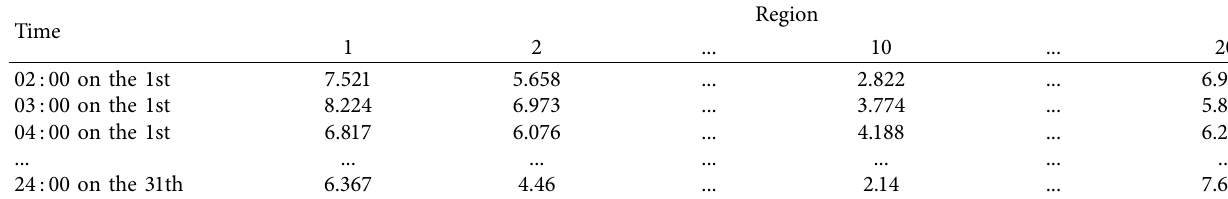
Table 2: Wind speed value of first fusion (m/s).